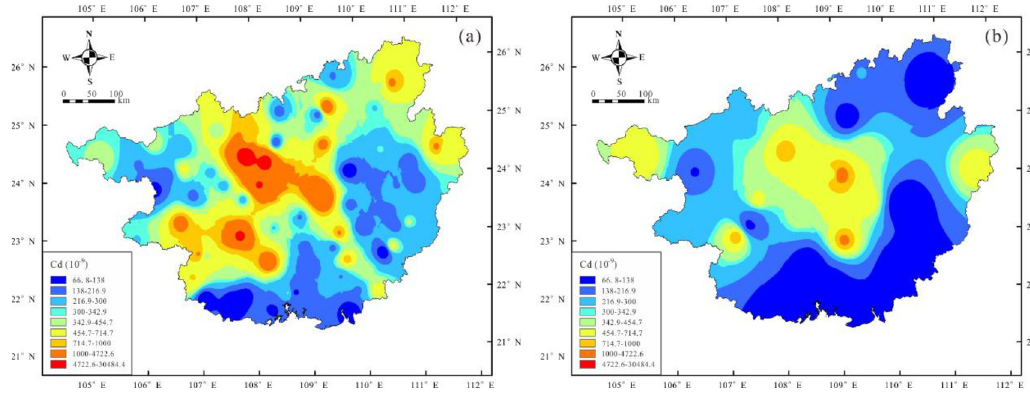
Fig 2. Guangxi Cd geochemical maps (a: CGB I, b: CGB II).